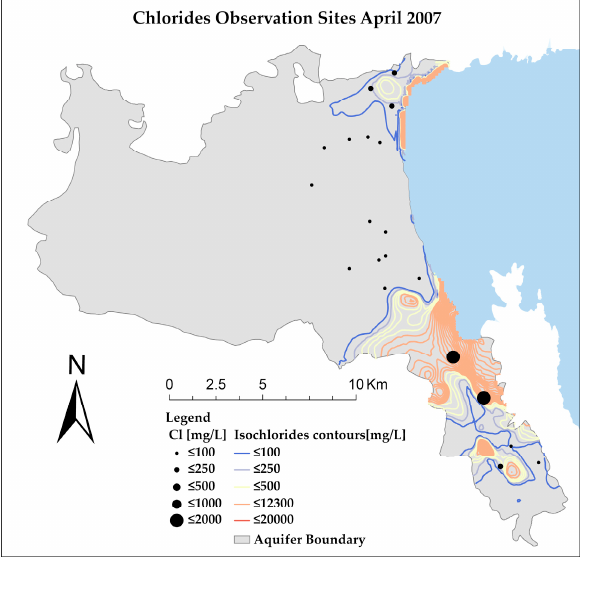
Figure 23. Isochlorides contours at the end of the simulation of seawater intrusion in September 2018. 5. Discussion Complex problems of the quantity and quality of water resources of coastal agricul ‐ tural watersheds, and especially of the groundwater regarding the water table depletion, the nitrate contamination, and the seawater intrusion, are encountered in the semi ‐ arid Mediterranean coastal region [1–18,23,28,29,32,39]. The developed integrated modeling system consisting of coupled and interrelated models of surface and groundwater hydrol ‐ ogy, crop growth/nitrate leaching, and groundwater contaminant transport and its appli ‐ cation in the Almyros basin, emphasize the significance of the integrated modeling for the study and the effective and accurate analysis of the spatiotemporal patterns of groundwa ‐ ter flow, nitrate pollution originated by fertilizer practices, and seawater intrusion [32].